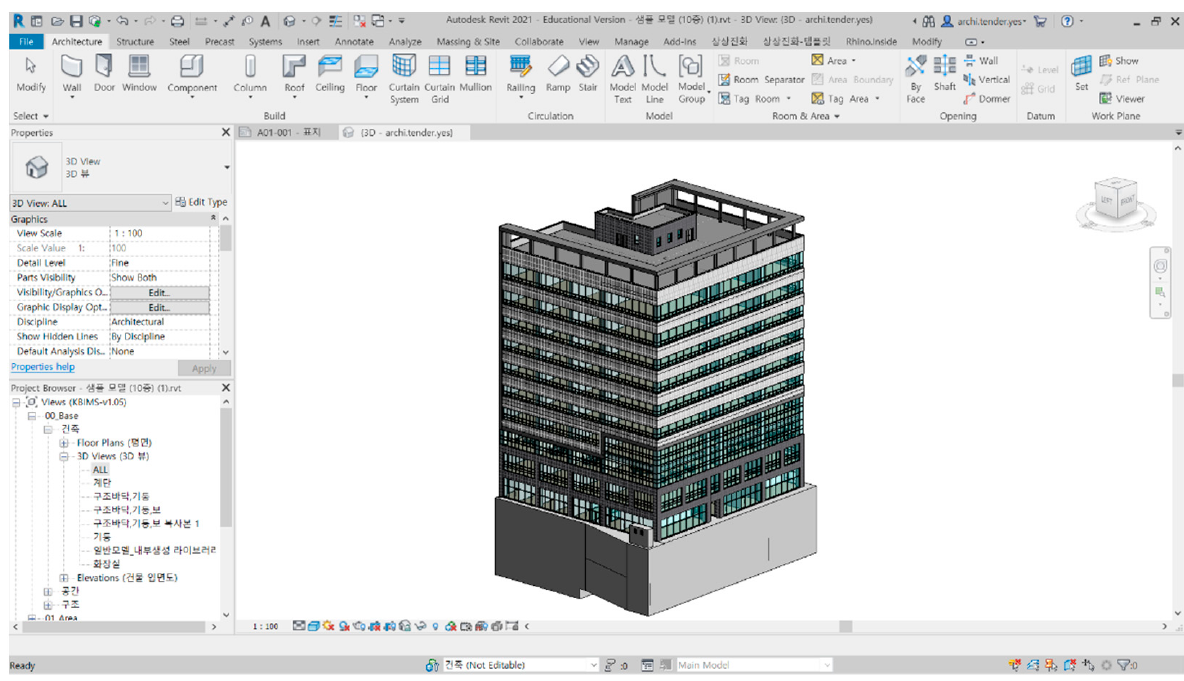
Figure 7. Test concept diagram of the common master standard module. The shape of the model created in Revit is shown in Figure 8.